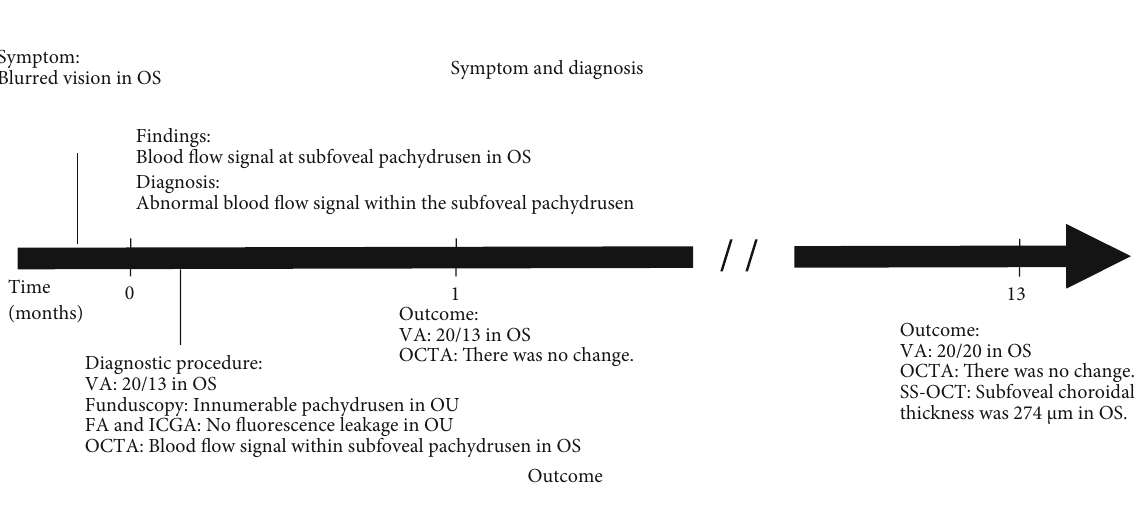
Figure 6: Clinical timeline of the female patient. OU: both eyes; FA: fl uorescein angiography; ICGA: indocyanine green angiography; OCT: optical coherence tomography; OCTA: OCT angiography; SS-OCT: swept source OCT; VA: corrected visual